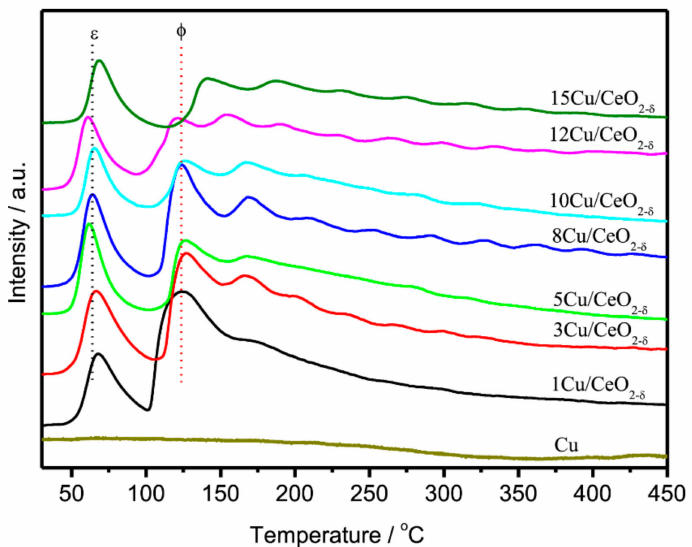
Figure 13. CO 2 -TPD analysis of the Cu/CeO 2- δ catalysts, reprinted with permission from [149]. Copyright Elsevier,